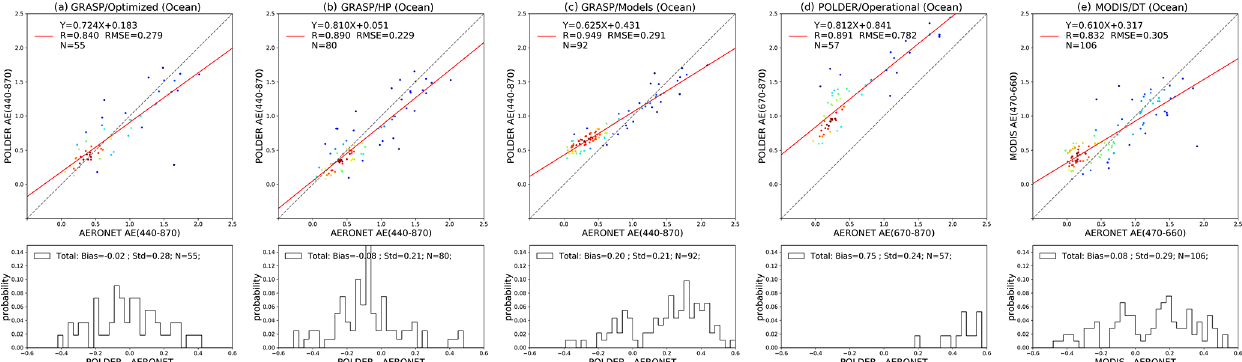
Figure 12. Validation of PARASOL/GRASP ( a GRASP/Optimized, b GRASP/HP and c GRASP/Models), (d) PARASOL/Operational and (e) MODIS/DT AE over ocean in 2008. The gray dashed line and the red solid line are the 1 : 1 reference line and the linear regression line. The probability density functions of differences (satellite–AERONET) are present in the lower